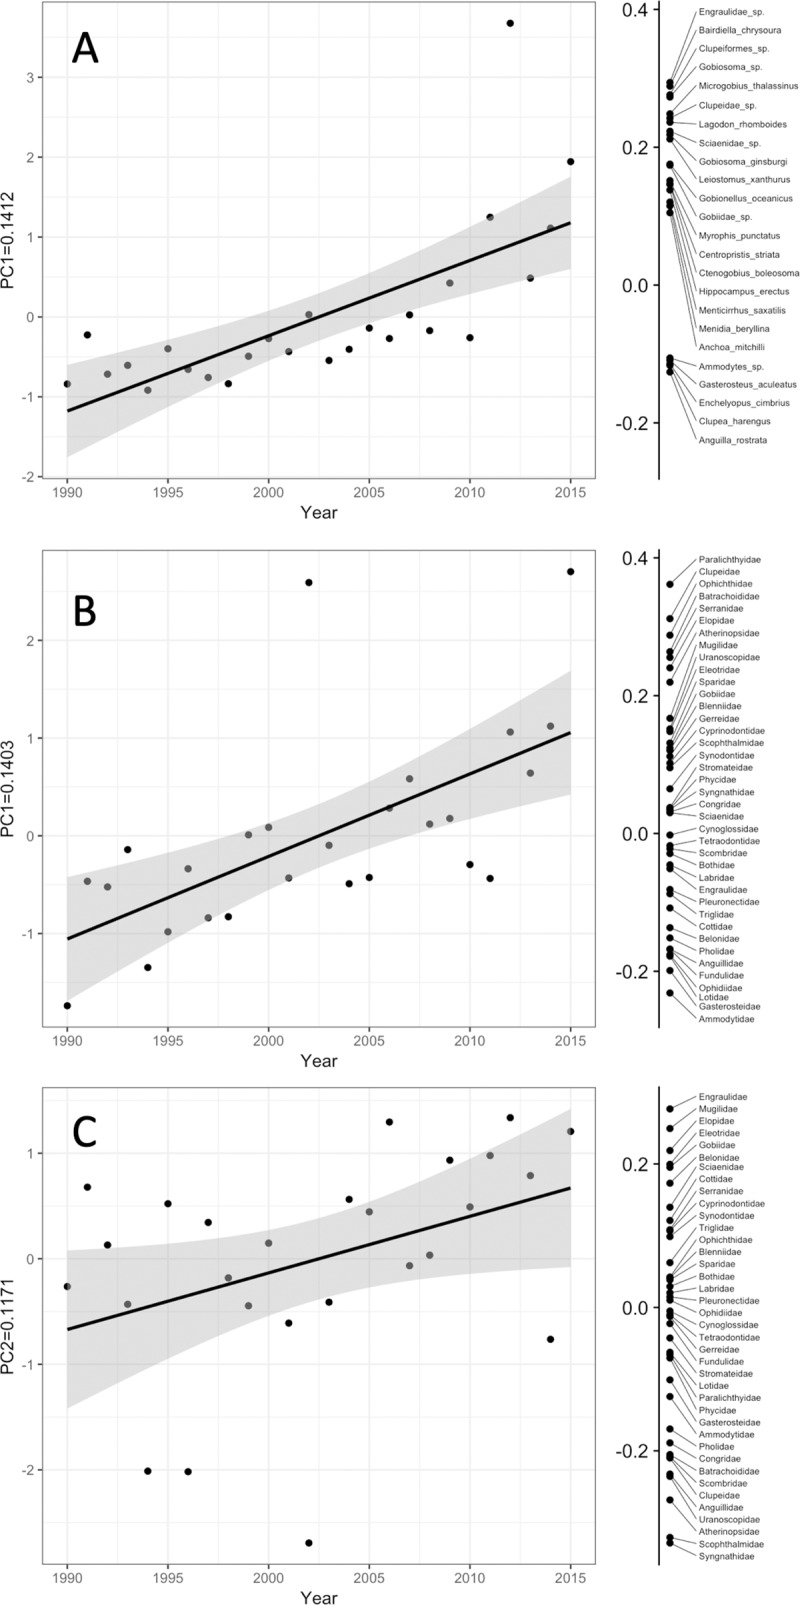
Principle component scores regressed across year (left panels) and species loading scores for the plotted principle component (right panel) for retained principle components from the species-level PCA (A) and the family-level PCA (B, first component and C, second component). *For panel A, all of the species loading scores would not fit vertically on the panel, so only those species scores that weighted heavily on the first principle component are included. See methods for details on selecting the number of principle components to retain.